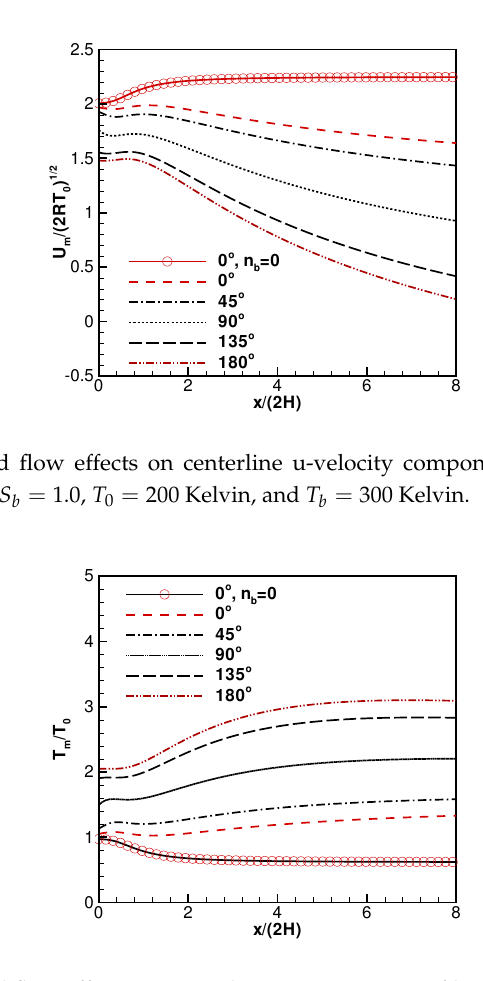
Figure 10. Background flow effects on centerline temperature profiles for the mixture, n b / n 0 = 0.2, S 0 = 2.0, S b = 1.0, T 0 = 200 Kelvin, and T b = 300